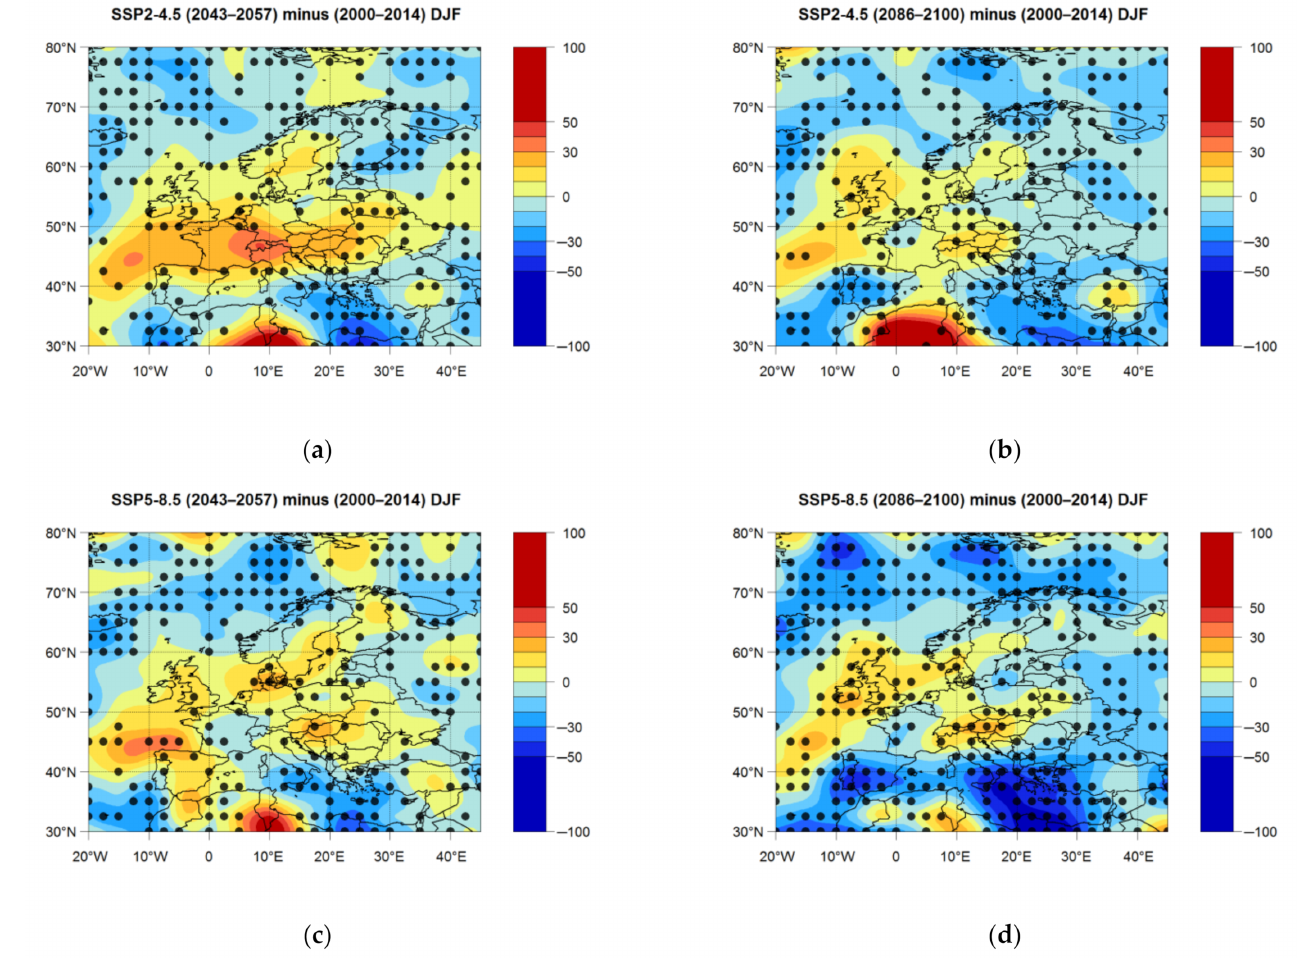
Figure A1. Anomalies (%) of the frequency of winter cyclones relative to the recent historical period (2000 to 2014) at the beginning of the century: ( a , c ) at the middle of the 21st century; ( b , d ) at the end of the 21st century; ( a , b ) under the SSP2-4.5 scenario; ( c , d ) under the SSP5-8.5 scenario. Stippling indicates where 70% of the models agree on the sign of